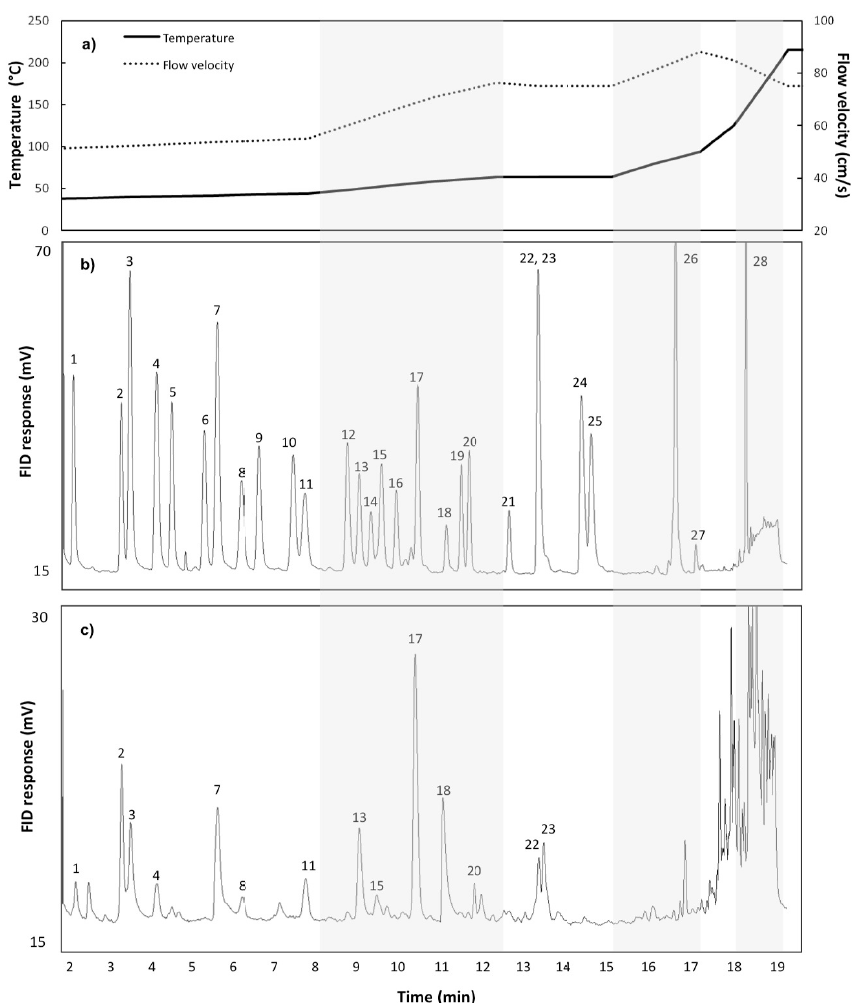
Fig. 4. (a) shows the temperature and carrier gas flow velocity programmes used for the GC_AMBIENT II method. (b) shows a chromato- graphic trace recorded using the GC_AMBIENT II method for analysis of VOC within an in-house prepared gas standard (containing ∼ ppb concentrations of BVOC and common anthropogenic VOC). (c) shows a chromatogram resulting from analysis of VOC in ambient air within a suburban forest (see Sect. 3.2.2 for details). Chromatographic peaks are labelled as follows; ethylbenzene(1), p-xylene + m-xylene(2), styrene(3), o-xylene(4), nonane(5), iso-propylbenzene(6), α -pinene(7), camphene(8), n-propylbenzene(9), 1,3,5-trimethylbenzene(10), β - pinene(11), 1,2,4-trimethylbenzene(12), myrcene(13), α -phellandrene(14), 1 -3-carene(15), α -terpinene(16), limonene(17), ocimene(18), unidentified terpene(19), γ -terpinene(20), terpinolene(21), linalool(22), α -terpineol(23), nopinone(24) limonene oxide(25), terpinen-4- ol(26), methyl chavicol(27), β -caryophyllene (28). Alternate shaded regions highlight changes in chromatography parameters (for more details, see Table